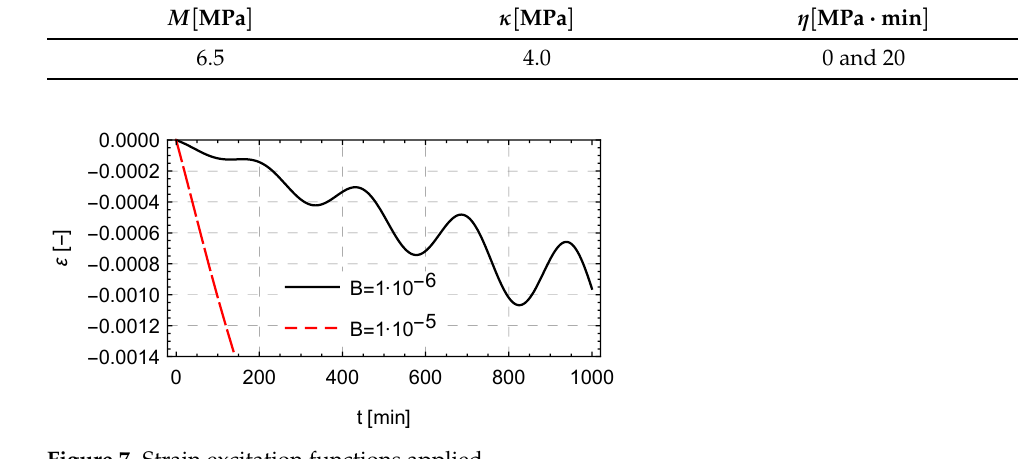
Figure 7. Strain excitation functions applied.